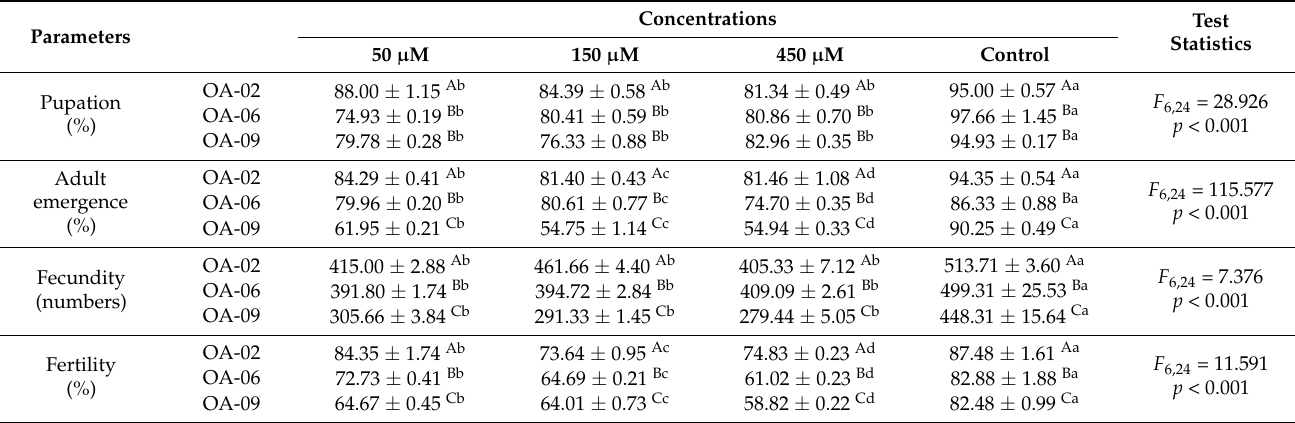
Table 5. Developmental and reproductive parameters of Helicoverpa armigera when treated with different concentrations of OA-02, OA-06 and OA-09